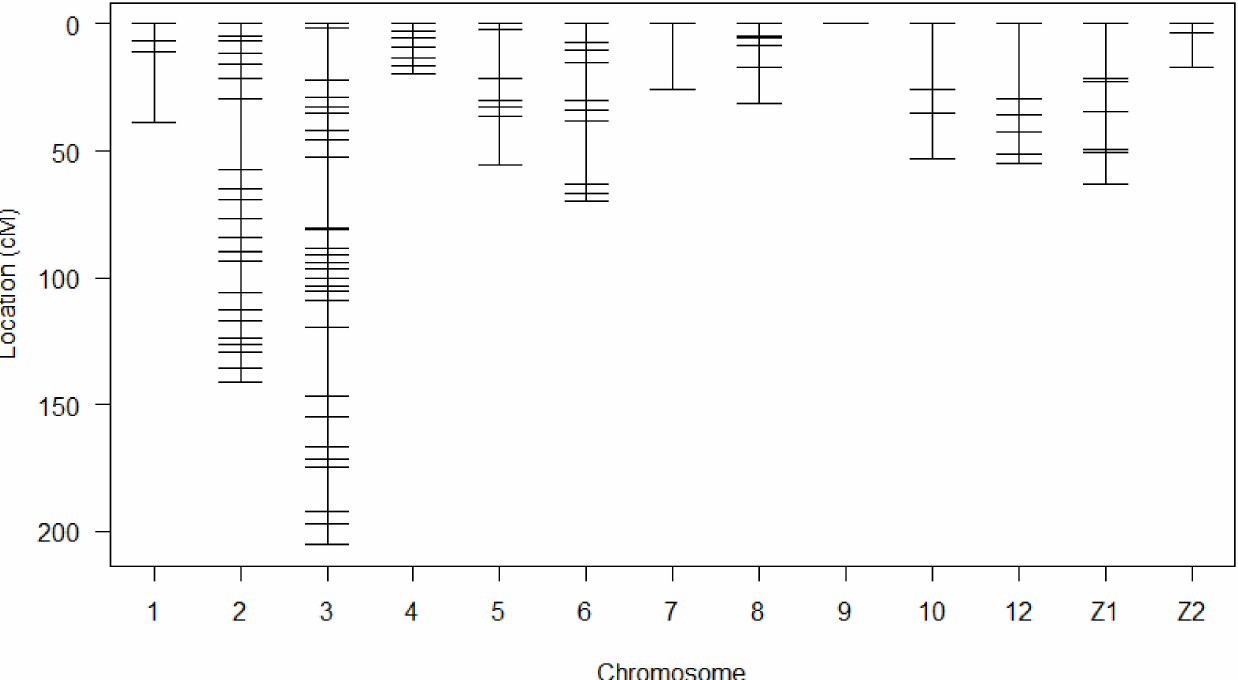
Figure 1. Genetic map of SNP markers distributed on 13 linkage groups. The abscissa shows the chromosome number. The ordinate presents the marker position based on